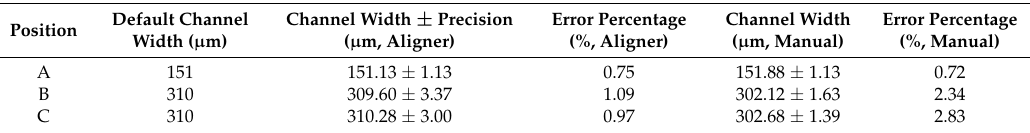
Table 2. Comparisons of the channel width at each location before and after aligned using aligner and manual alignment.